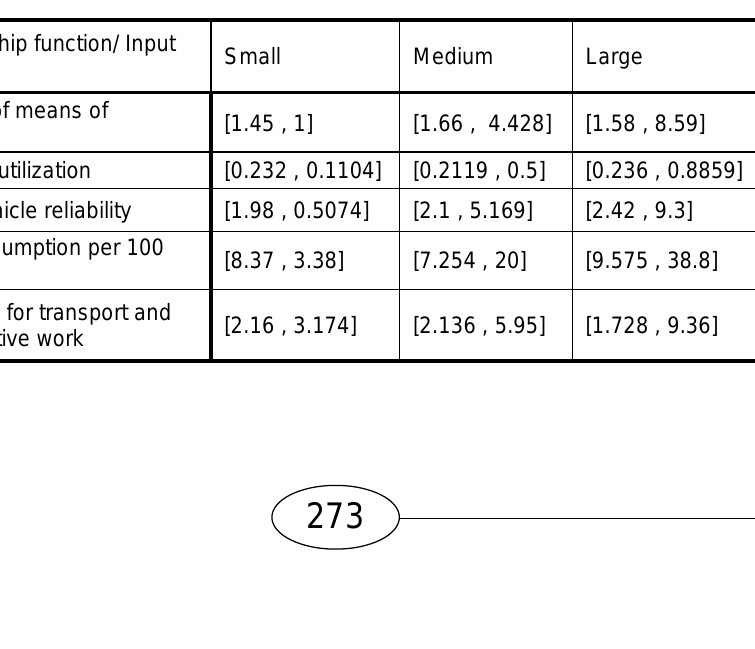
Figure 6 – Membership functions of the output variable Рис. 6 – Функции принадлежности выходной переменной Слика 6 – Функције припадности излазне променљиве Table 3 – Values of the membership functions of the input variables Таблица 3 – Значения функций принадлежности входных переменных Табела 3 – Вредности функција припадности улазних